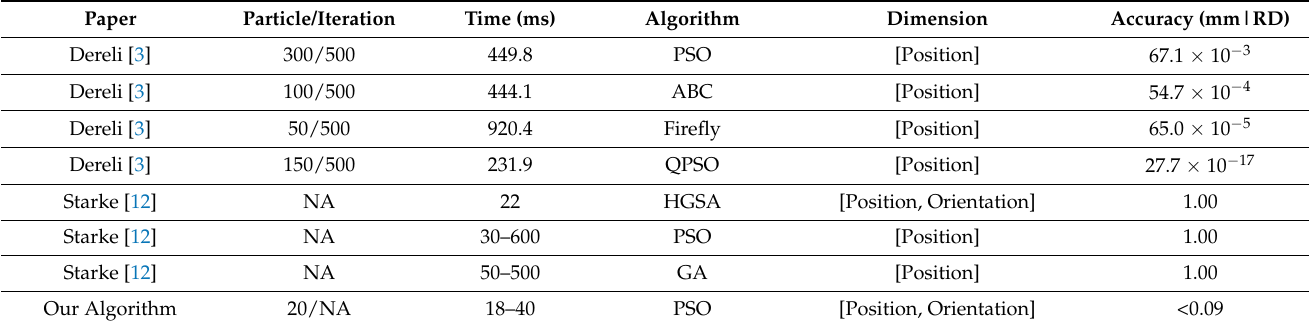
Table 5. Comparison of our algorithm with other swarm intelligence methods.